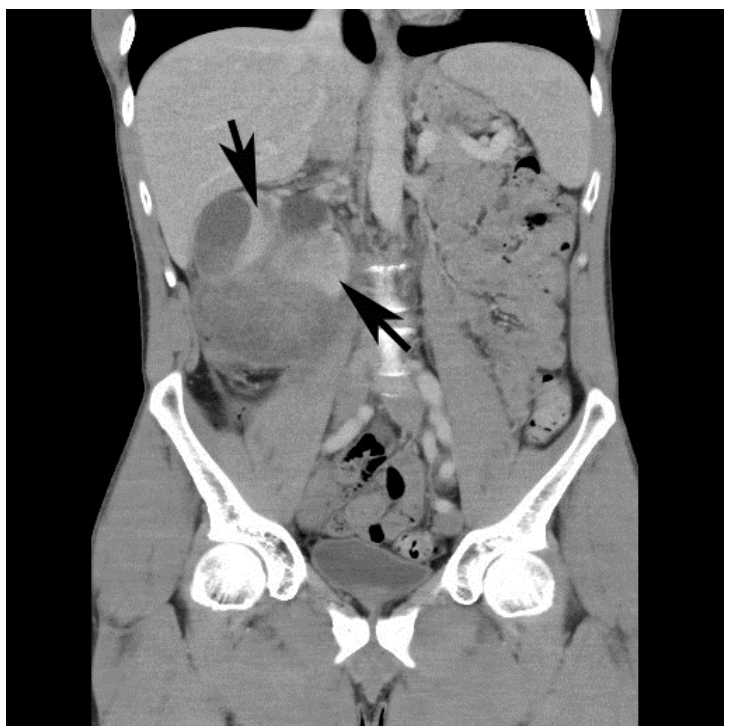
Figure 2. CT scan – coronal view showing right kidney mass with subcapsular haematoma